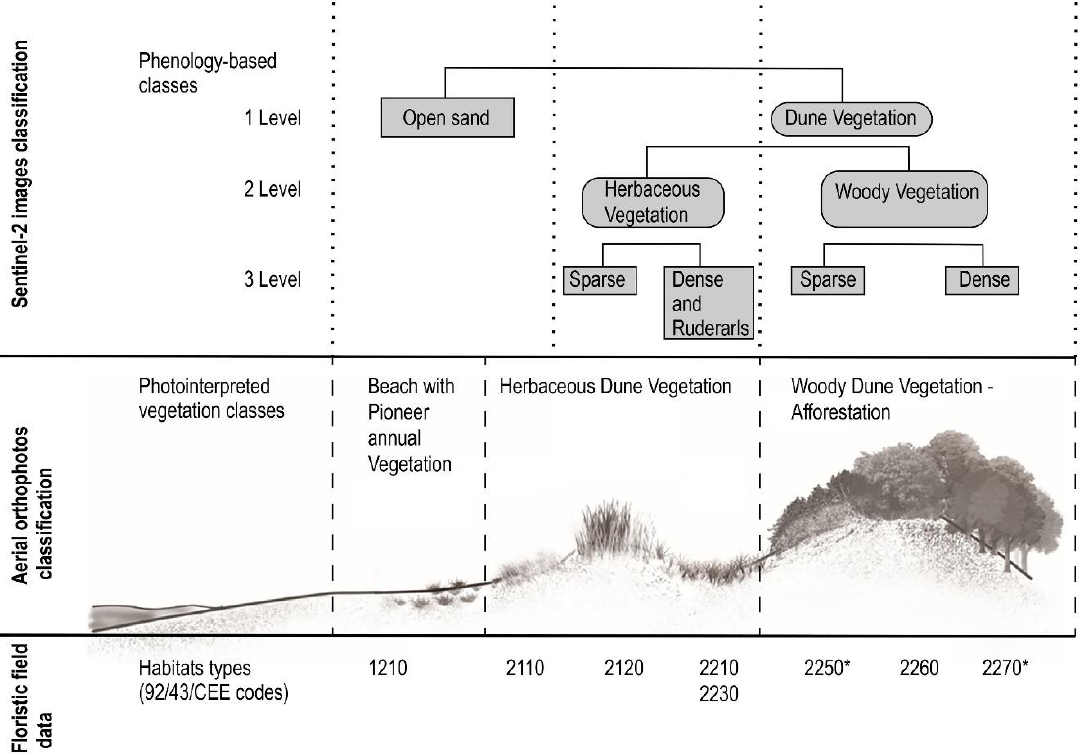
Figure 5. Cross sectional diagram indicating a typical coastal dune zonation along with their corresponding phenology-based classes, habitat types (92 / 43 / EEC; for full habitat names see Table 1) and vegetation classes mapped in a previous study [76].